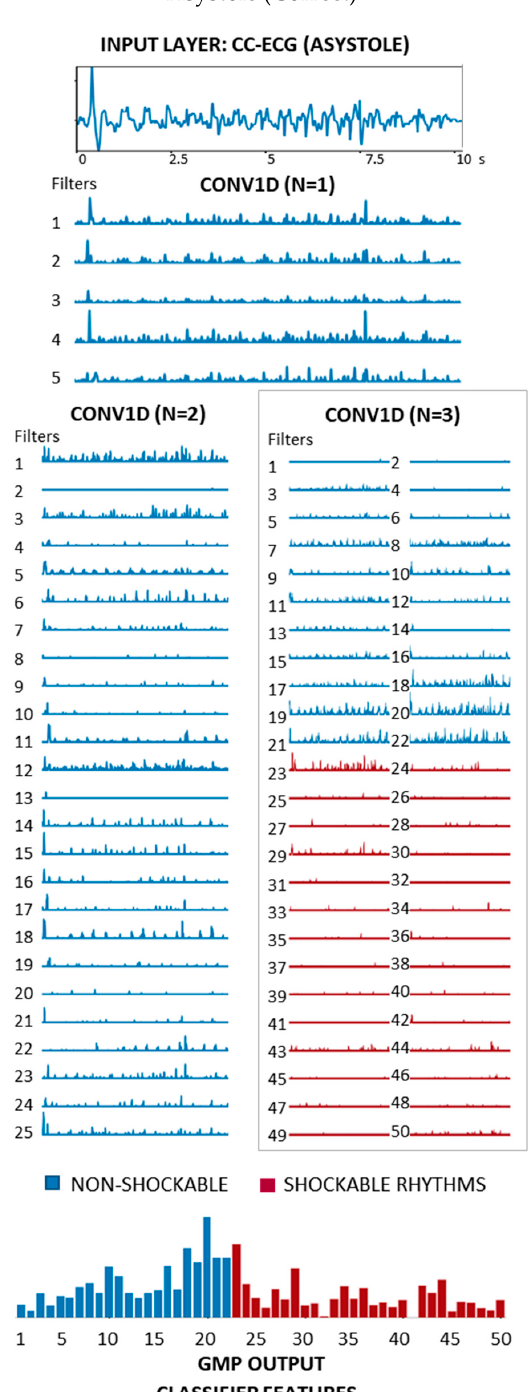
Figure 9. Features of CNN3-CC-ECG network computed for two examples of 10 s ECG-CC strips annotated as OR (Figure 1) with different shock advisory decisions: ( a ) OR (SNR = − 14.6 dB) correctly detected as NSh rhythm with output proba- bility pSh = 0.001; ( b ) OR (SNR = − 18.4 dB) erroneously detected as Sh rhythm with output probability pSh = 0.858. The underlined 50 filters at the output of CONV1D (N = 3) are used for computation of 50 classifier features (bottom plot), grouped for Sh (red) and NSh (blue) rhythms in accordance with the sign of the classifier weights.